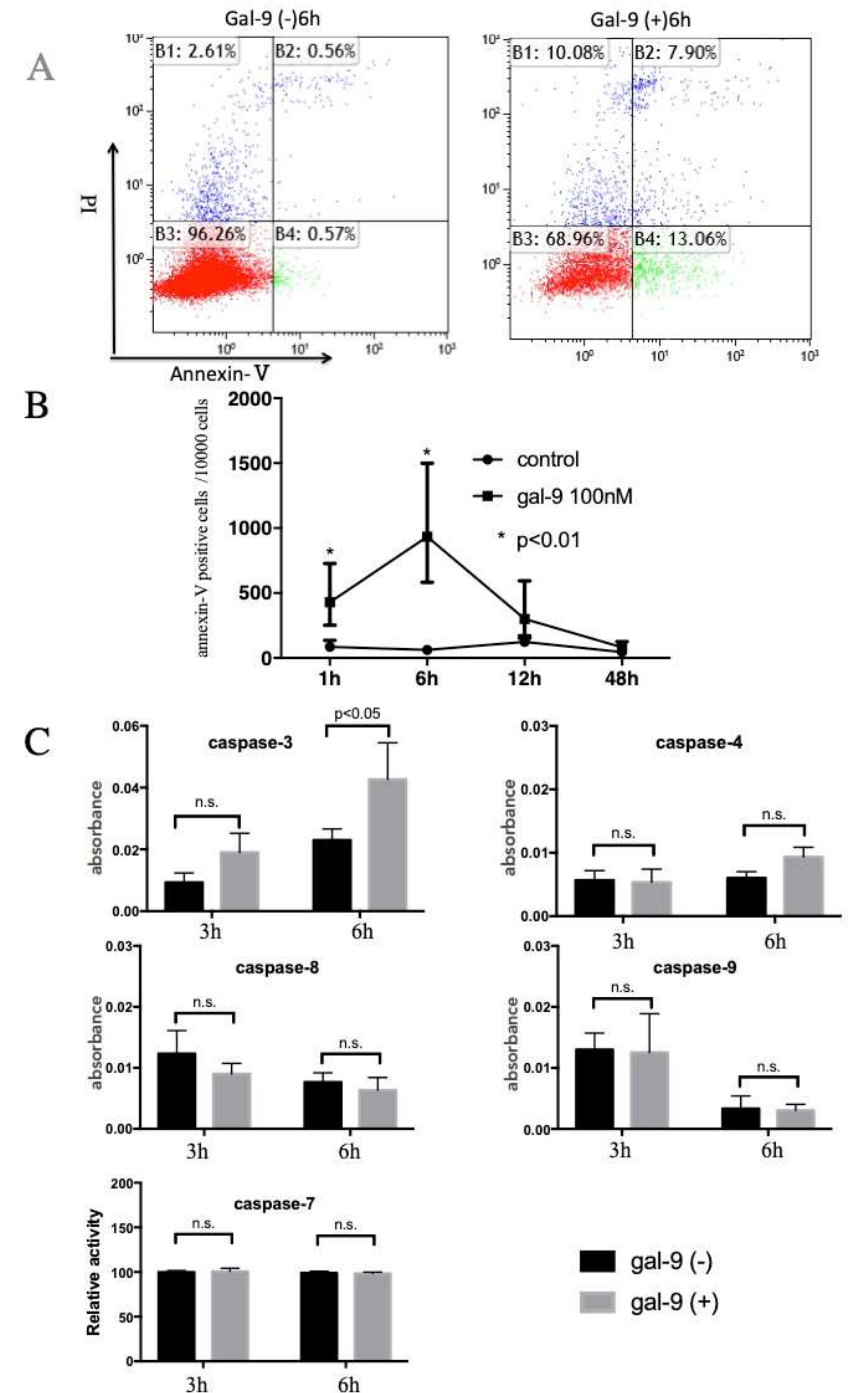
Figure 2. Gal-9 induces apoptosis of ESCC cells. ( A ) Early apoptosis analysis in KYSE-150 cells 6 h after the administration of Gal-9. The lower left quadrant represents viable cells (red dots), the lower right quadrant early apoptotic cells (green dots), and the upper right quadrant indicates the late apoptotic or necrotic cells (blue dots); ( B ) The transition of Annexin V-positive cell number following treatment with Gal-9 for 1, 6, 12, and 48 h. Annexin V-positive cells were significantly increased at 1 h and 6 h after Gal-9 treatment, compared to the control; ( C ) The activation of caspase-3 was observed after 6 h of treatment with 100 nM Gal-9, as evaluated with the colorimetric assay. No significant change in the activity of caspase-4, -7, -8 and -9 was observed. The error bars represent 95% CI.